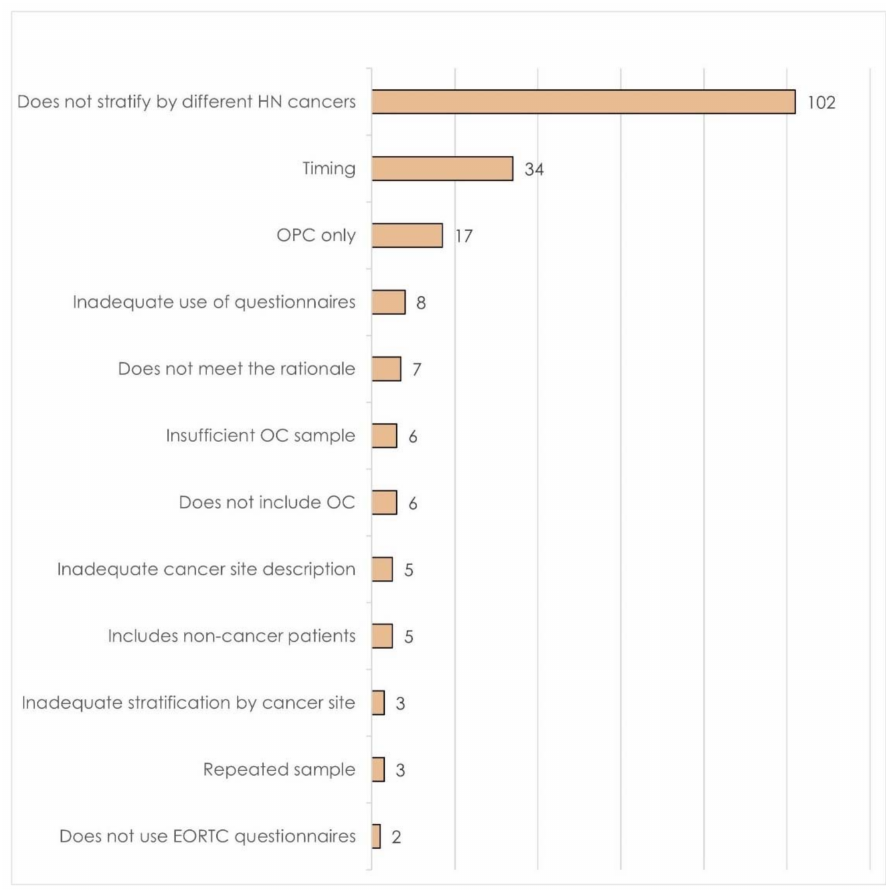
Figure 2. Reasons for the exclusion of the screened